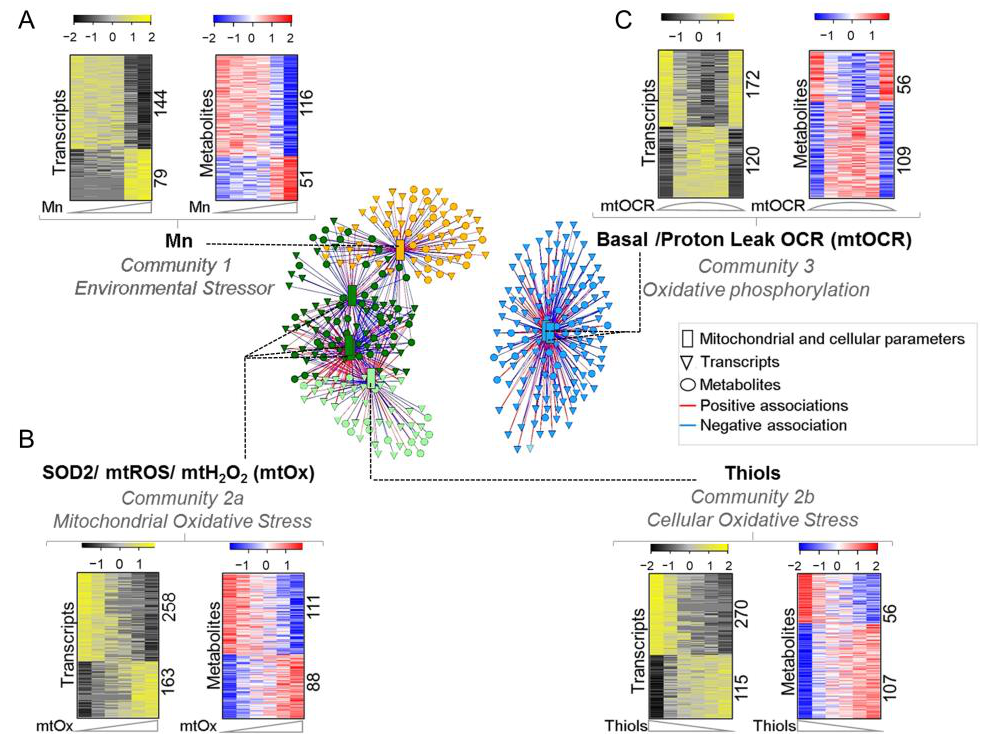
Figure 1. Data-driven integrative analysis defined 3 communities with transcriptome and metabolome interaction with mitochondrial-cellular parameters [MCP] in response to Mn dose. Three major communities generated through PLS regression method for pairwise data integration using xMWAS v0.54 at |r| > 0.9. ( A ) Community 1 (yellow)—environmental stressor subnetwork comprising intracellular Mn positively associated with 79 genes and 51 metabolites and negatively associated with 144 genes and 116 metabolites. ( B ) Community 2 (green)—oxidative stress subnetwork further bifurcated into two sub-communities at |r| > 0.8—communities 2a and 2b. Community 2a (dark green)—mitochondrial oxidative stress (mtOx) subnetwork community comprising SOD2, mtROS and mtH 2 O 2 positively associated with 163 genes and 88 metabolites and negatively associated with 268 genes and 111 metabolites. Community 2b (light green)—cellular oxidative stress subnetwork comprising total cellular thiols positively associated with 270 genes and 56 metabolites and negatively associated with 115 genes and 107 metabolites. ( C ) Community 3 (blue)—oxidative phosphorylation subnetwork (mtOCR) comprising basal OCR and proton leak dependent OCR, positively associated with 120 genes and 109 metabolites and negatively associated with 172 genes and 56 metabolites. Seven MCPs are represented as rectangles, genes as triangles and metabolites as circles. Red edges represent positive, while blue represents negative associations with their respective MCPs. |r| > 0.8, p < 0.05.